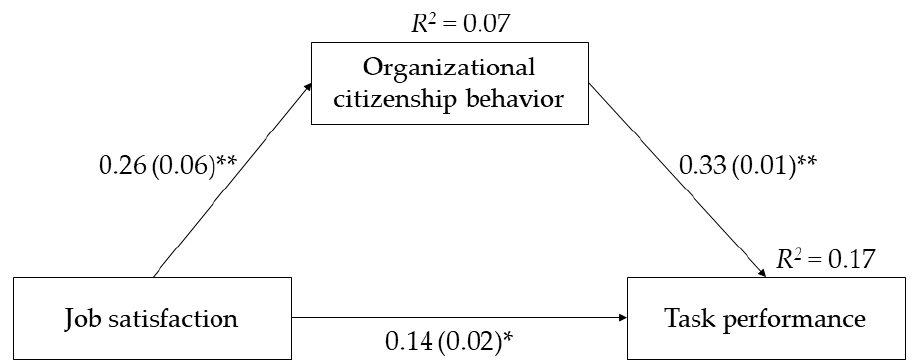
Figure 2. The mediation model. Standardized path estimates are displayed. Standard errors are in parentheses. Covariates are omitted from the figure for clarity. * p < 0.01; ** p < 0.001. Table 5. Multi-group analyses on the moderating role of